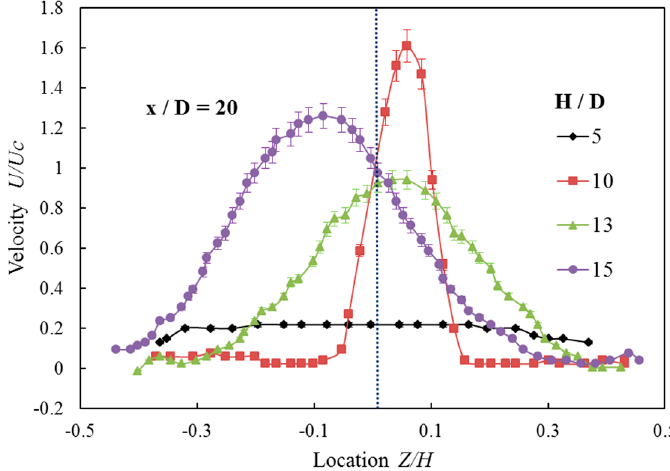
Figure 8. Axial mean velocity of the vertical plane ( X - Z ).